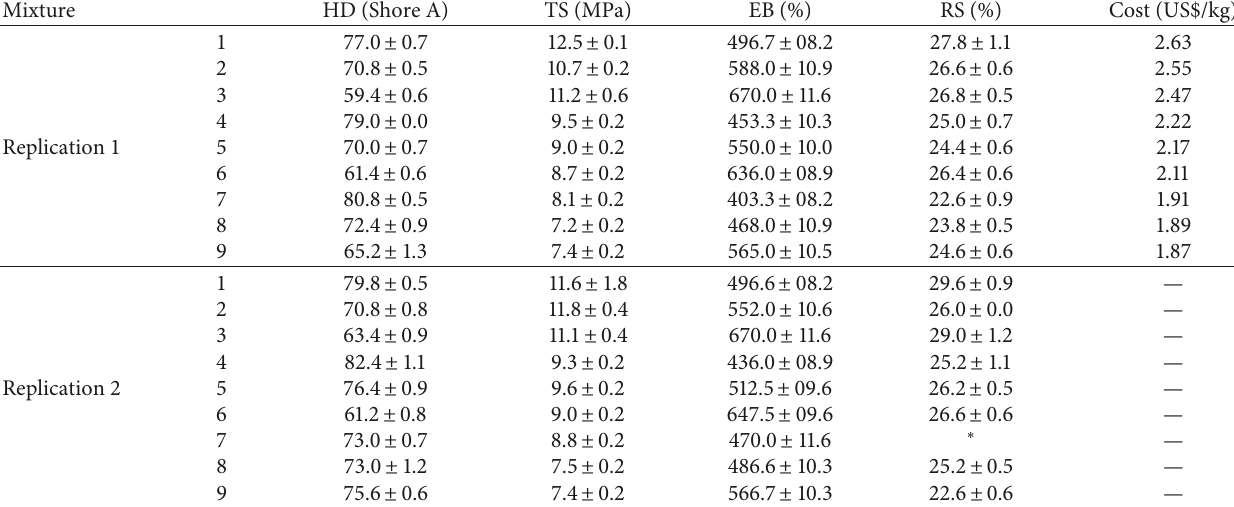
Table 4: Measured values of hardness (HD), tensile strength (TS), elongation at break (EB), rebound resilience (RS), and material costs (CT) for the nine designed mixtures in two replications. Mixture